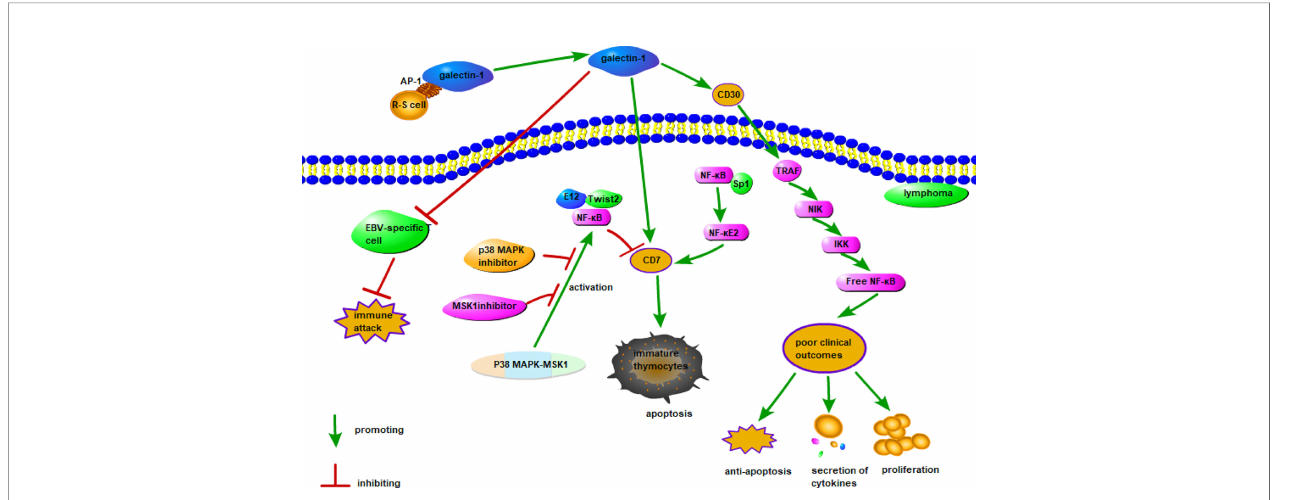
FIGURE 1 | Possible mechanism of galectin-1 in lymphoma. The combination of AP-1 on the surface of R-S cells and galectin-1 promotes the expression of galectin-1, the combination of overexpressed galectin-1 and CD30 stimulates tumor necrosis factor – associated factor and activates the NF- k B signaling pathway to produce poor clinical outcomes. The combination of galectin-1 and CD7 induces apoptosis of immature thymocytes, the combination of NF- k B and Sp1 promotes the expression of CD7, while the combination of E12 and Twist2 with NF- k B inhibits the expression of CD7. Since the p38 MAPK-MSK1 pathway regulates CD7 expression by activating NF- k B, inhibitors of the p38 MAPK and MSK1 pathways can directly reduce CD7 expression. In addition, EBV-speci fi c T cells binding to galectin-1 may inhibit immune